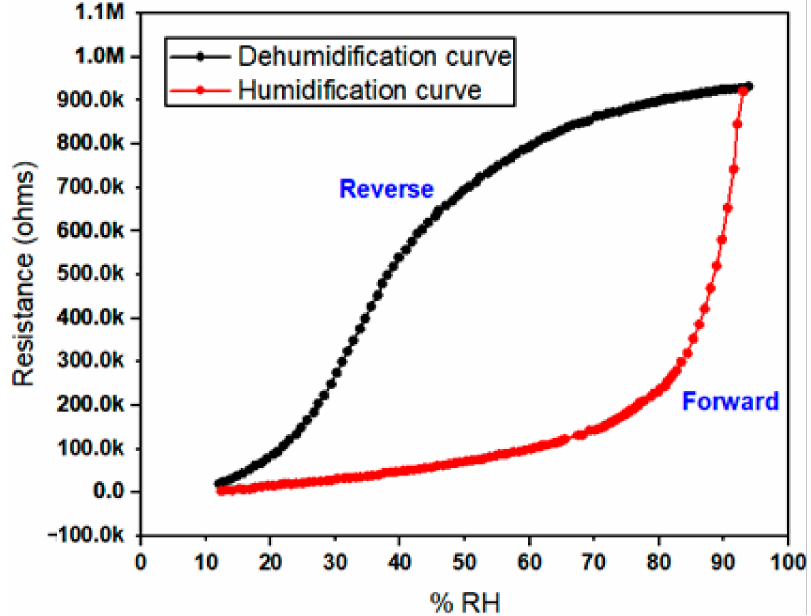
Figure 10. Resistance verses % RH graph showing humidification and dehumidification hysteresis cyclic curve at a lower frequency of 100 Hz and at 1